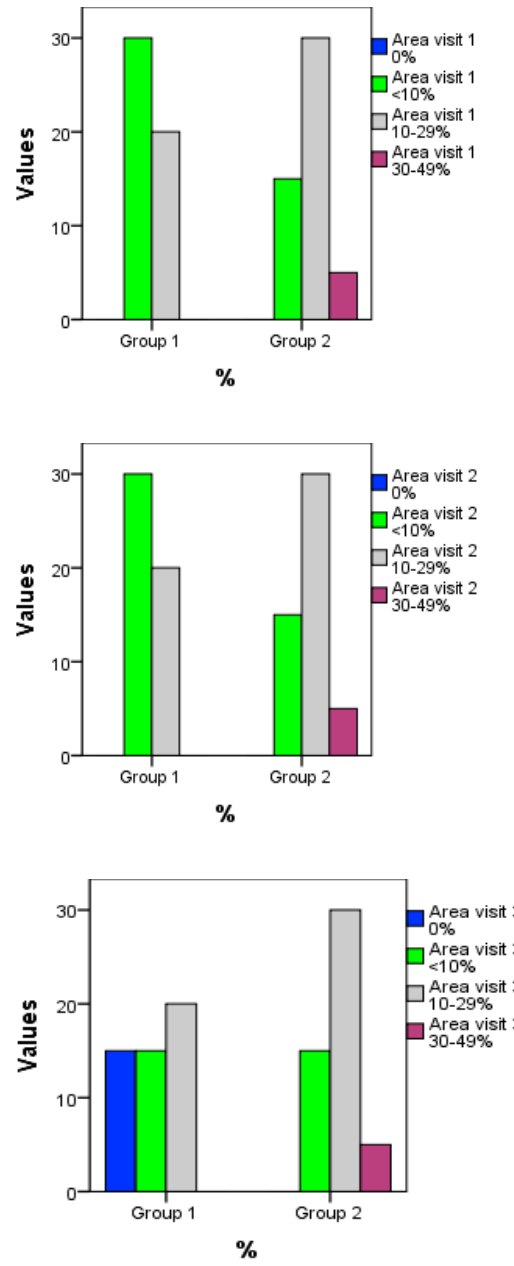
Figure 7. Graphic presentation of the percentage of the affected area in the 3 visits, at the two research groups. The treated group is represented by Group 1 and the placebo group is represented by Group 2.